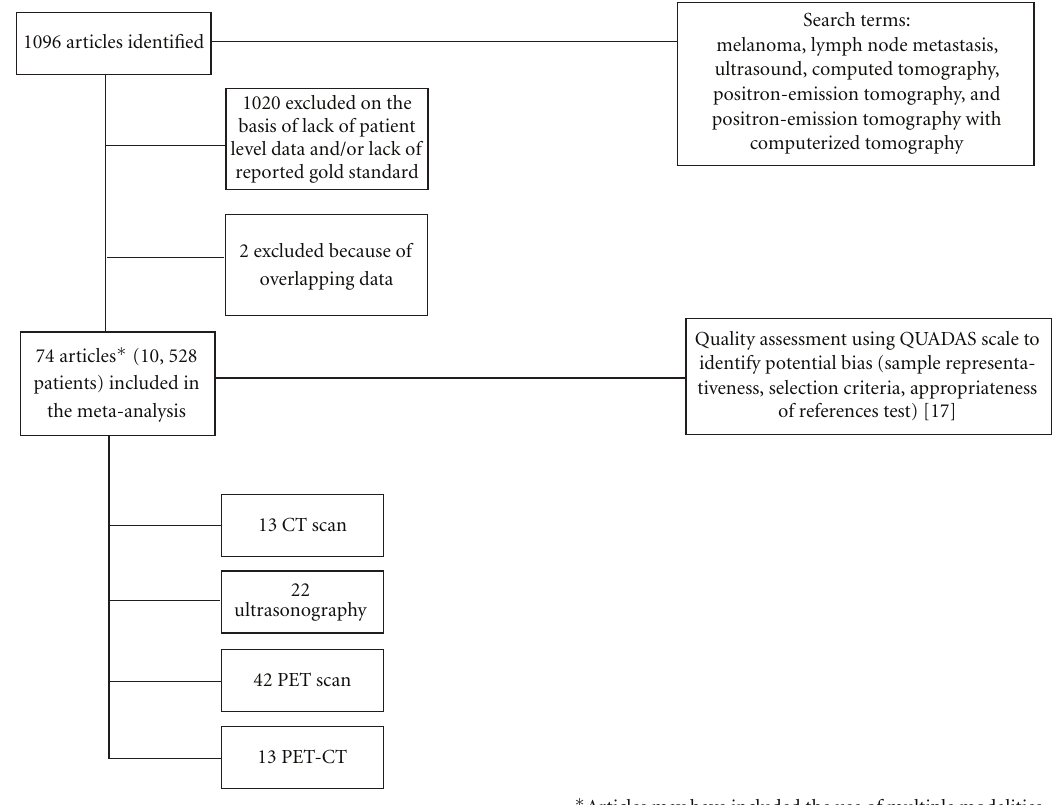
Figure 1: Meta-analysis selection